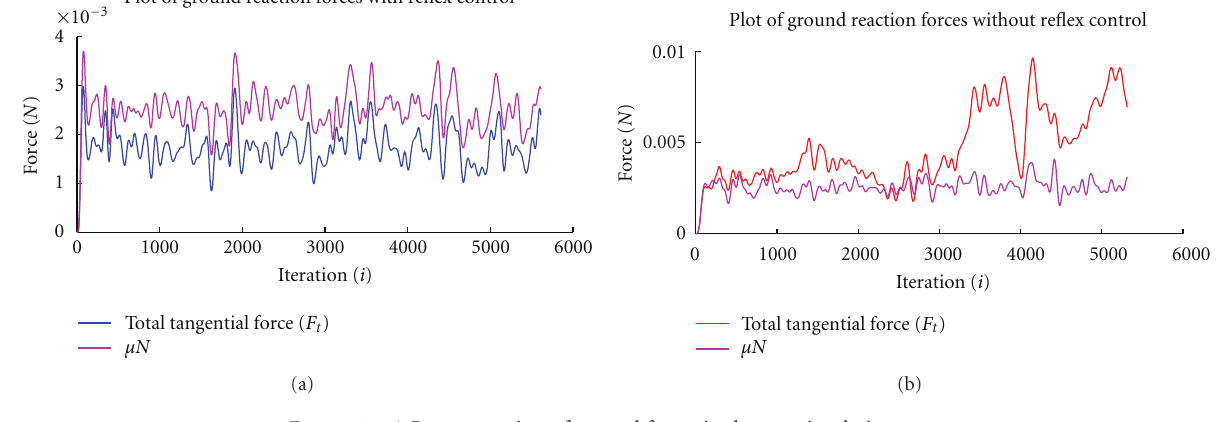
Figure 17: A Representation of ground forces in the two simulation tests.